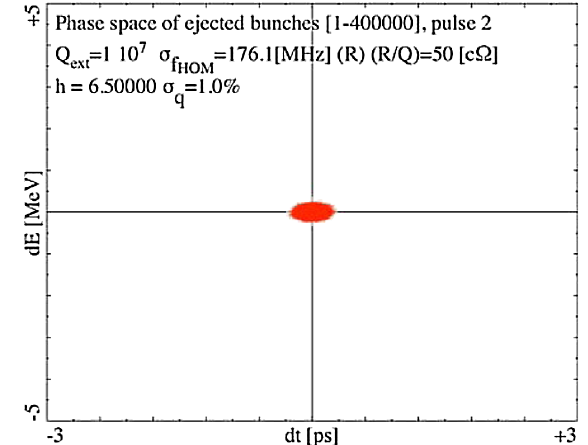
FIG. 33. (Color) dE as a function of I B for two consecutive pulses with Q ext ¼ 10 7 , (cid:1) (cid:3) f ¼ 100 kHz ; red: worst bunch in pulse; blue: rms; filled upward triangles: with 1% charge scatter; hollow downward triangles: without bunch